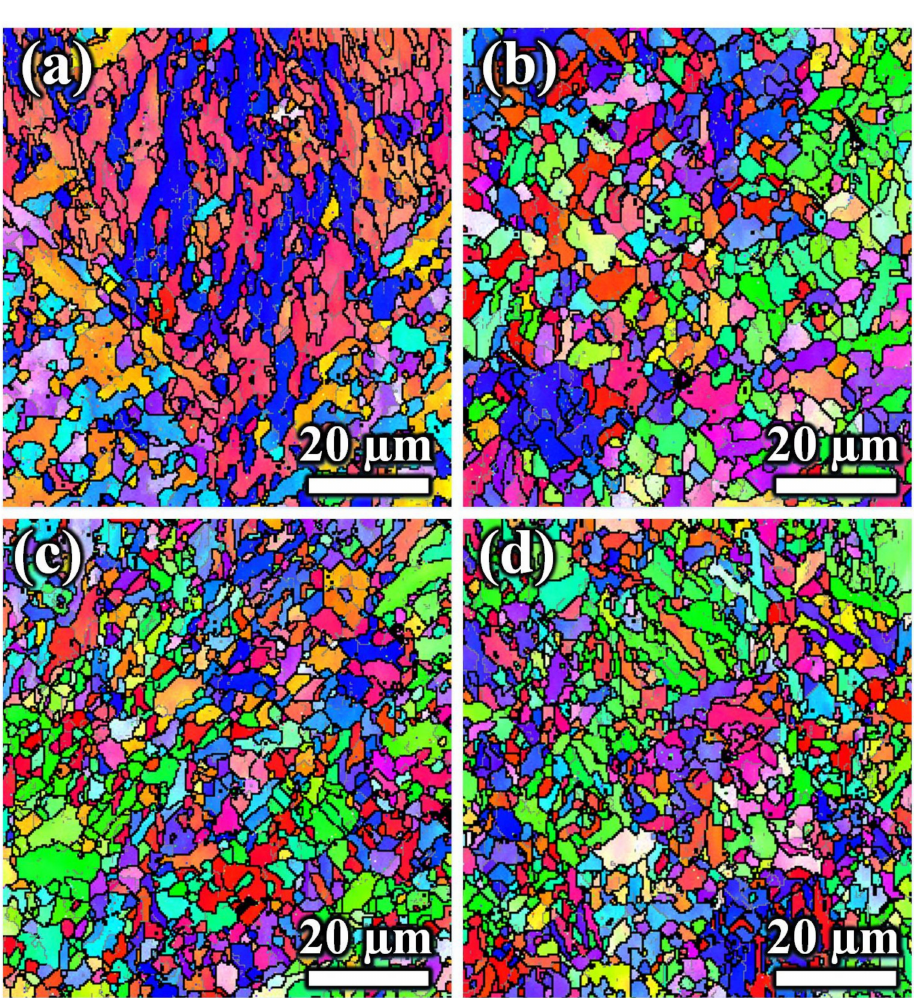
Figure 4. EBSD images of H13 steels without and with different types and contents of nanoparticles: